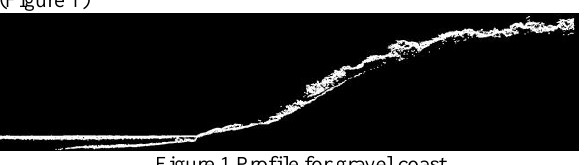
Figure.1 Profile for gravel coast.